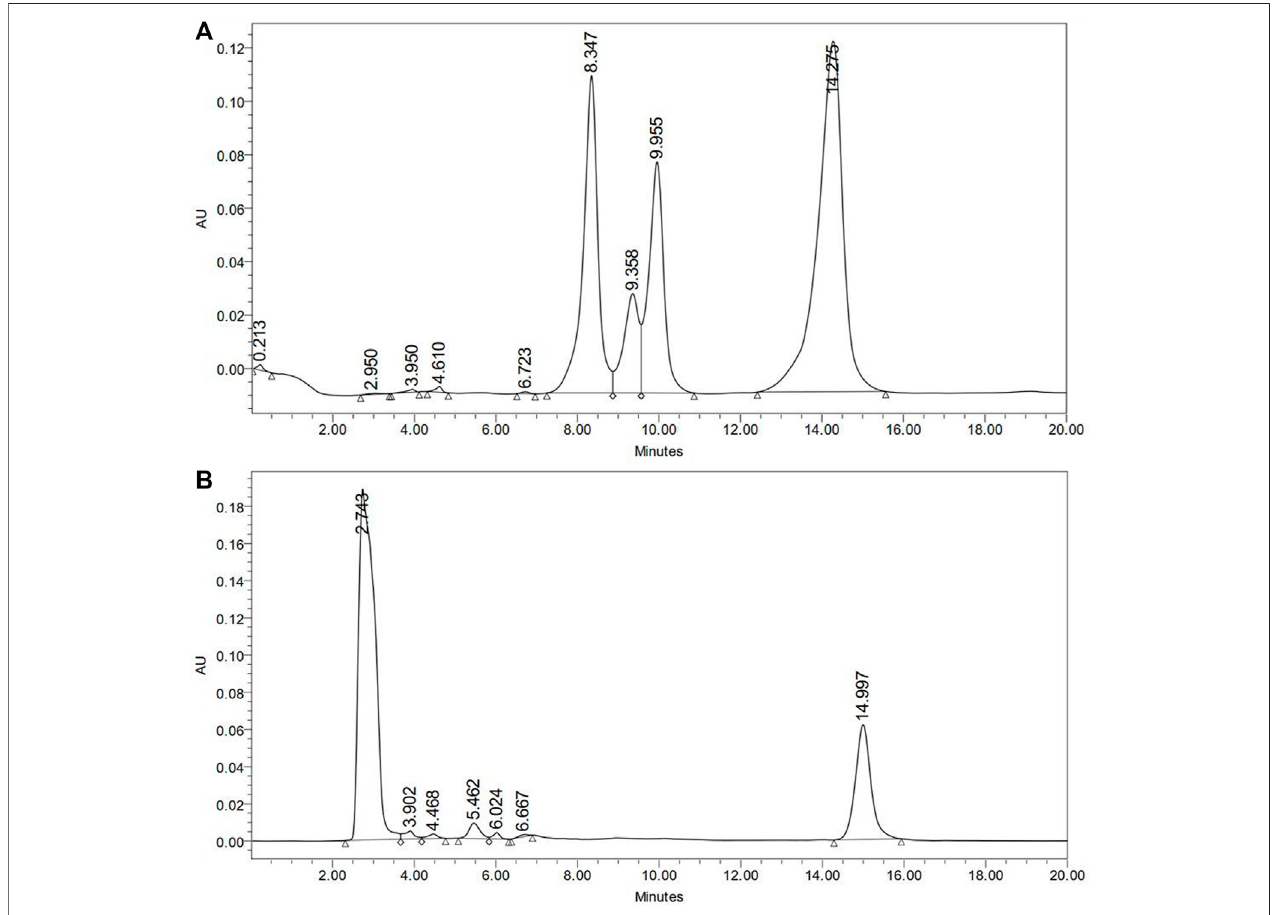
FIGURE 5 | HPLC estimation of deltamethrin on P. americana exposed to 1% deltamethrin. (A) HPLC-UV chromatogram of insecticides mixture including deltamethrin used as standard; Pyriproxifen (9.358 min), chloropyriphos (9.995 min), and deltamethrin (14.275 min); (B) HPLC-UV chromatogram for deltamethrin extracted from whole cockroach; deltamethrin (14.997